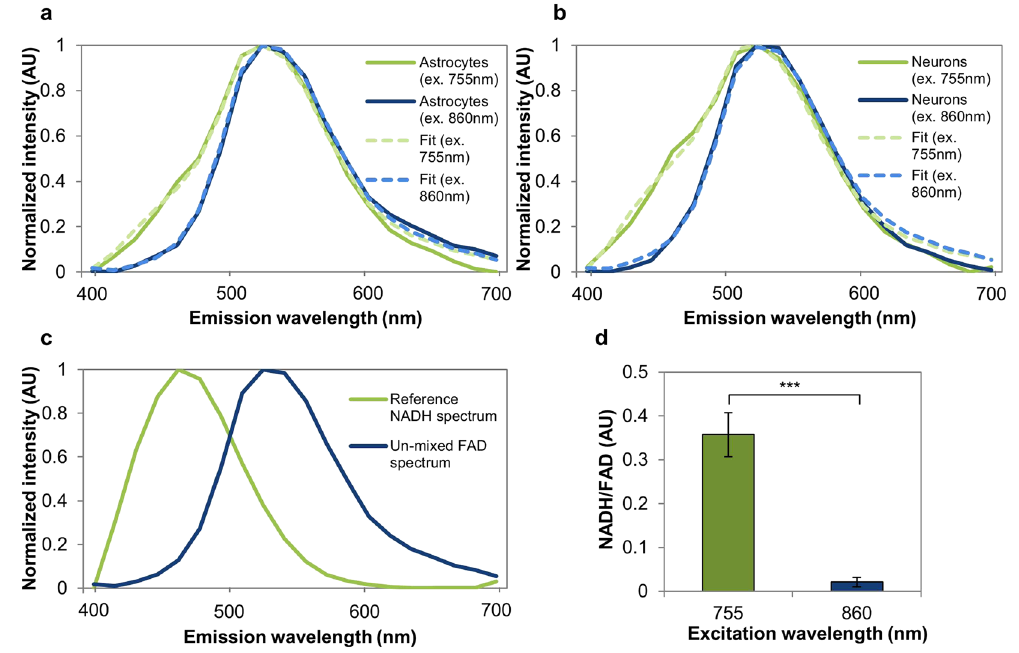
Figure 1. Cell emission spectra show features characteristic of NAD(P)H and FAD. ( a ) Astrocyte and ( b ) neuron emission spectra are broader at 755 nm excitation relative to 860 nm, consistent with emission of both NAD(P)H and FAD at 755 nm, but only FAD at 860 nm. ( c ) Spectral un-mixing with a reference NAD(P)H spectrum yields a second component consistent with FAD’s known emission spectrum. ( d ) The relative weight of NAD(P)H/FAD is significantly higher at 755 nm excitation than 860 nm, consistent with a low excitation efficiency of NAD(P)H at 860 nm. *** p <